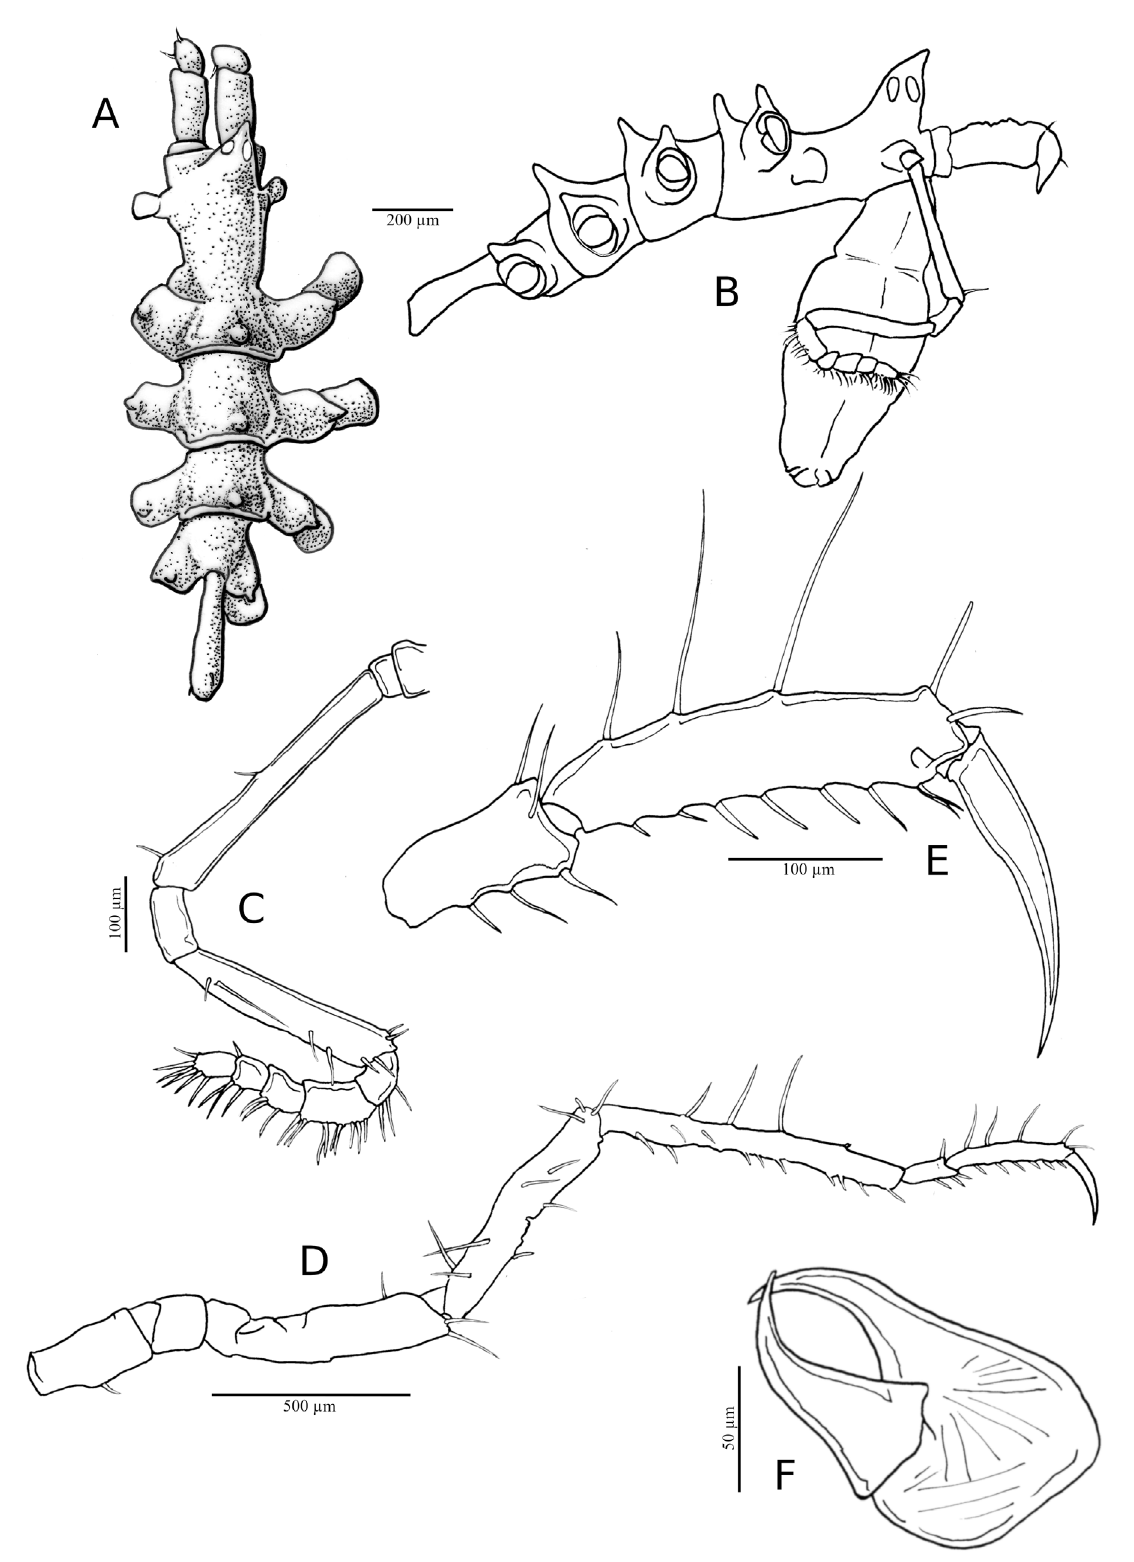
Fig. 8. Ascorhynchus sp. 5, juvenile, MNHN-IU-2016-1039. A . Body, dorsal view. B . Body, lateral view (same scale as A). C . Palp. D . First leg. E . Tarsus and propodus of first leg. F .